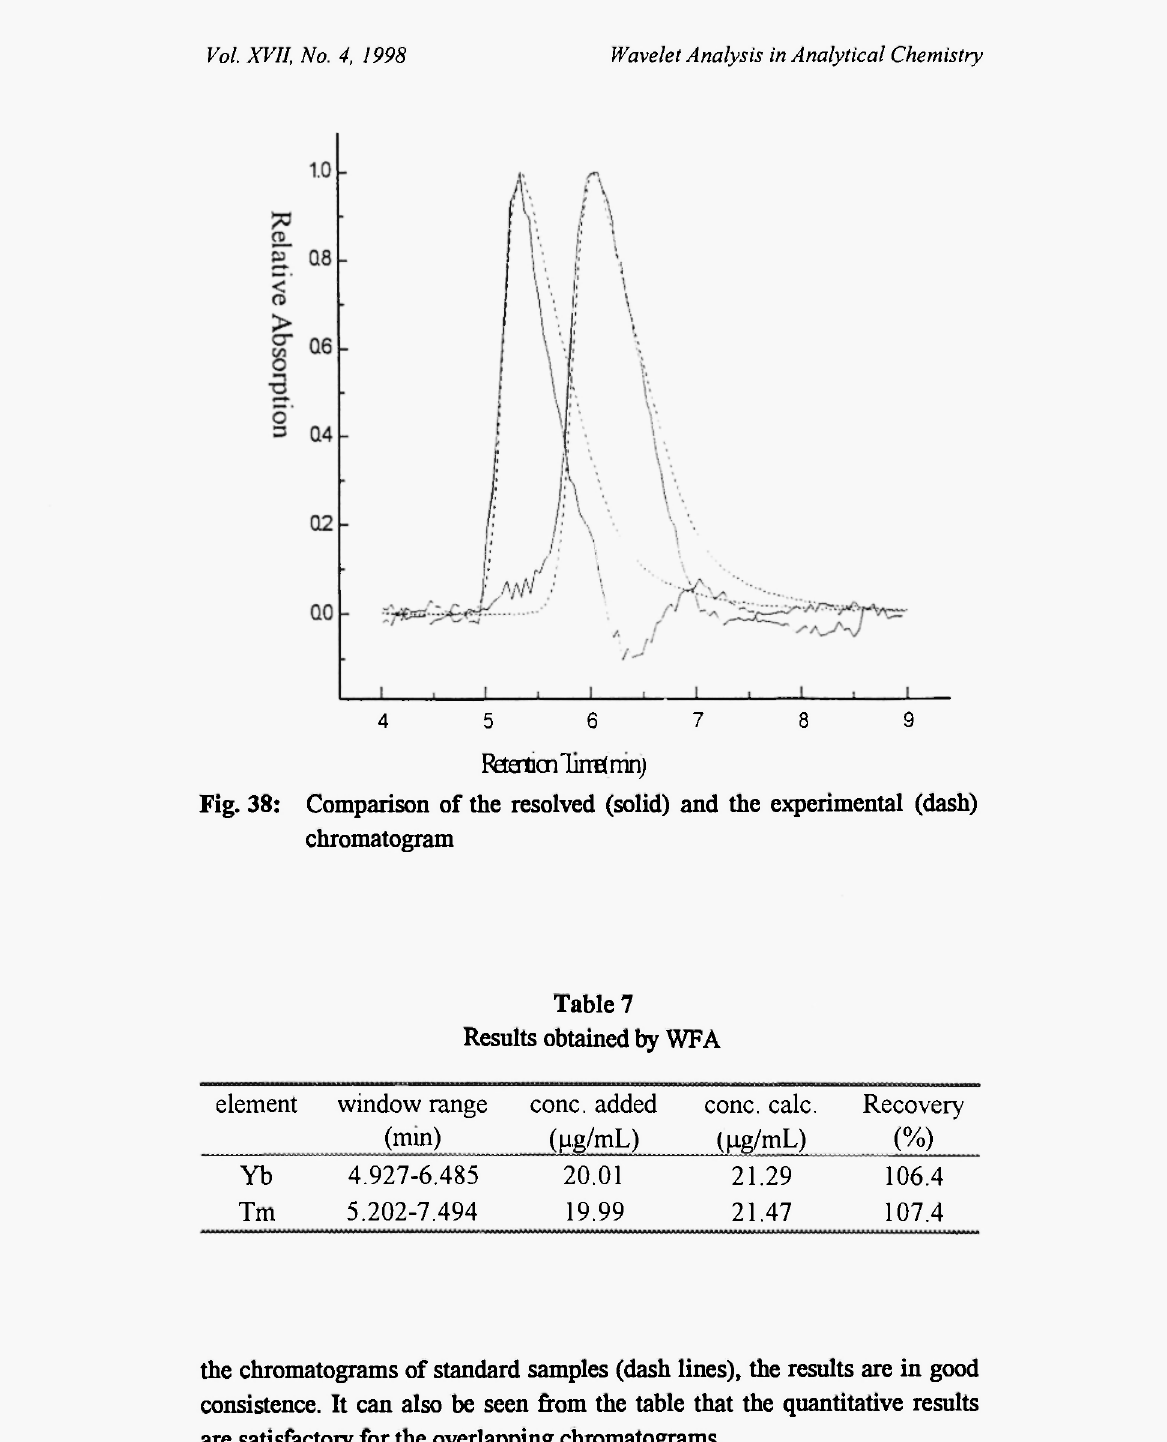
Results obtained by WFA element window range conc. added conc.